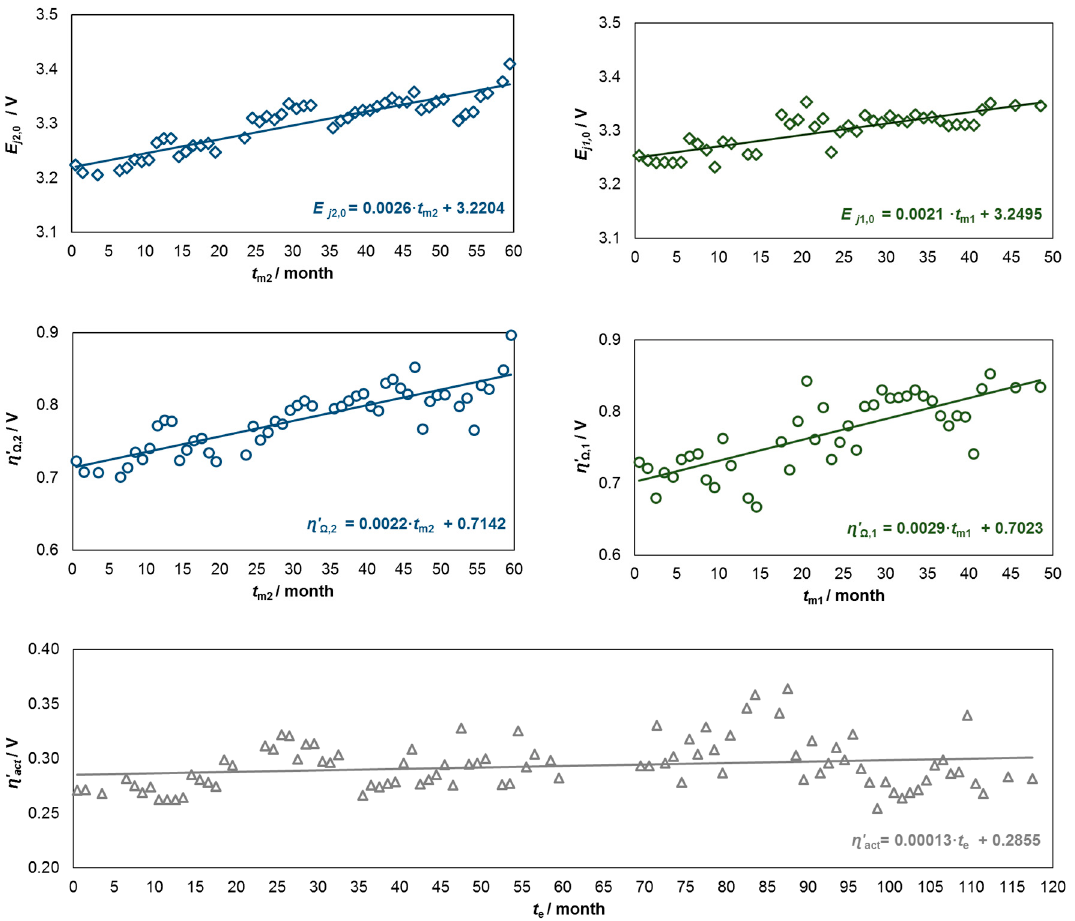
Figure 6. ( a ) Normalized potential, E ji ,0 , as a function of the respective membrane service time, t mi ; ( b ) associated ohmic overpotential, ɳ Ω ’, as a function of the respective membrane service time, t mi ; and ( c ) associated activation overpotential, ɳ act ’, as a function of the respective electrode time, t e . Table 1. Regression analysis of the E ji,0 , ɳ Ω ,I ’ and ɳ act ’ as a function of the respective service times